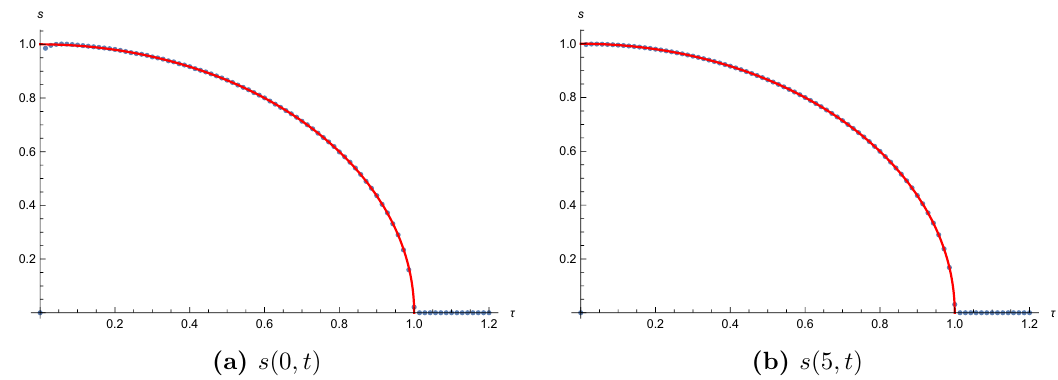
Figure 3. Plot of s ( (cid:12); t ) for (a) (cid:12) = 0 and (b) (cid:12) = 5. The horizontal axis is the rescaled time (cid:28) = t= 2 N . The blue dots are the exact values of s ( (cid:12); t ) at N = 500 while the red curve represents p the semi-circle law s = 1 (cid:0) (cid:28) 2